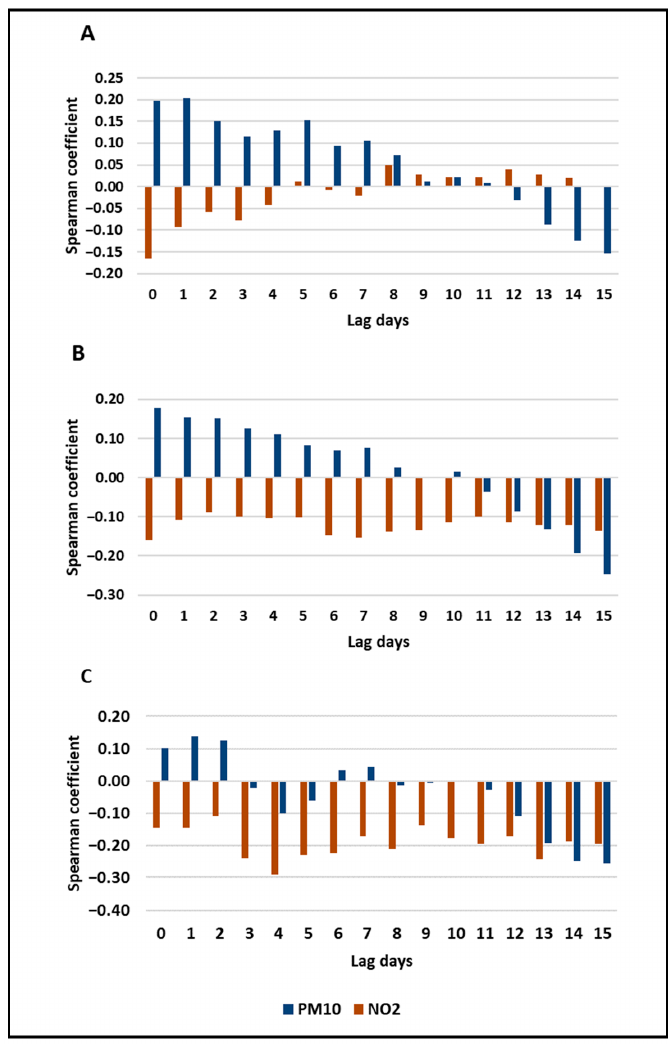
Figure 6. Variation of the Spearman coefficient (bars) for new cases ( A ), total cases ( B ), and mortality ( C ) with the air quality variables in CABA. The lag day indicates up to 15 days prior to the confirmation date of cases and deaths.